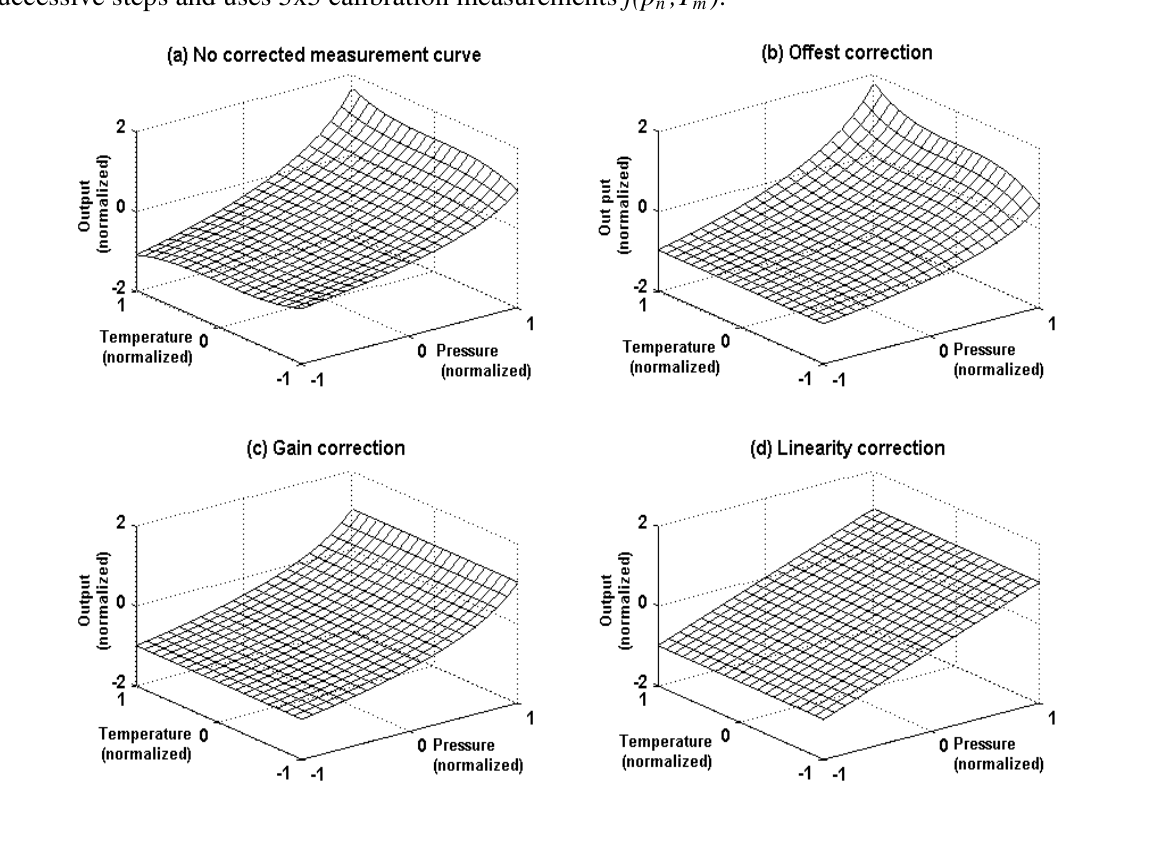
Figure 5. Corrections of a 2-dimensional measurement